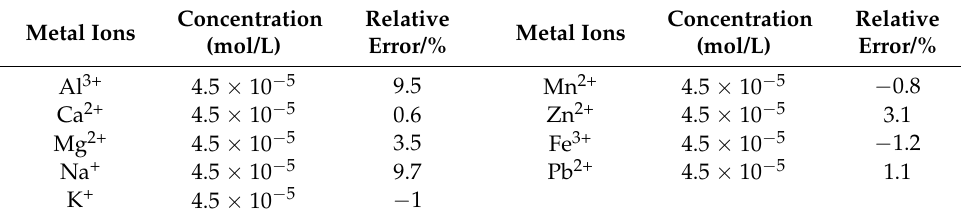
Table 1 . Effect of 9 metal ions on the determination of Ag + (Ag + = 4.5 × 10 − 5 mol/L) . Metal Ions